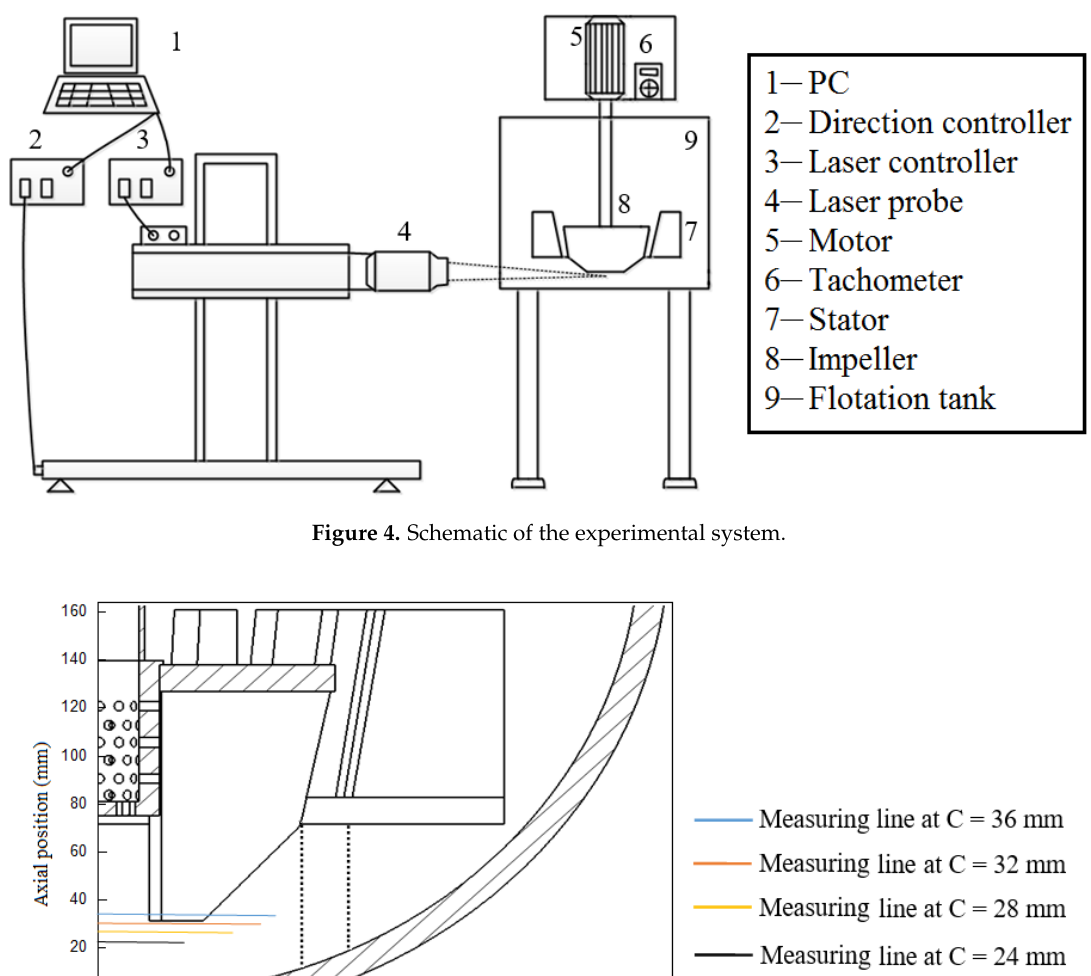
Figure 3. Half medial vertical plane in the KYF flotation machine.